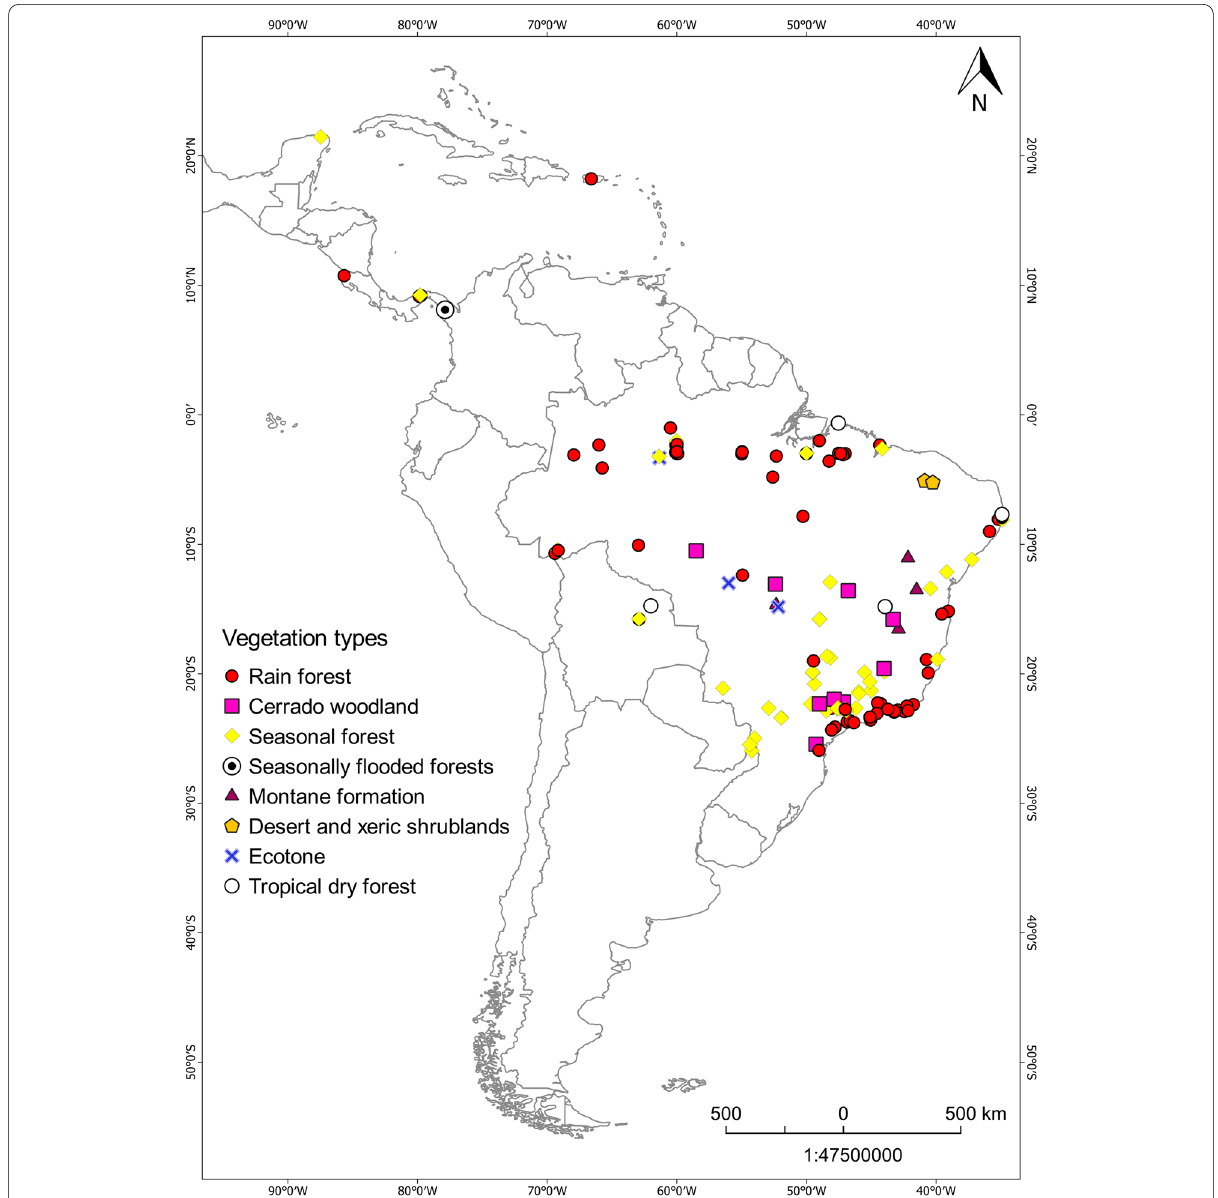
Fig. 2 Geographical distribution of the studies that evaluated strategies of management occurring on lianas across neotropical region. Vegetation classification follows Mendoza et al. (2017) after Olson et al.